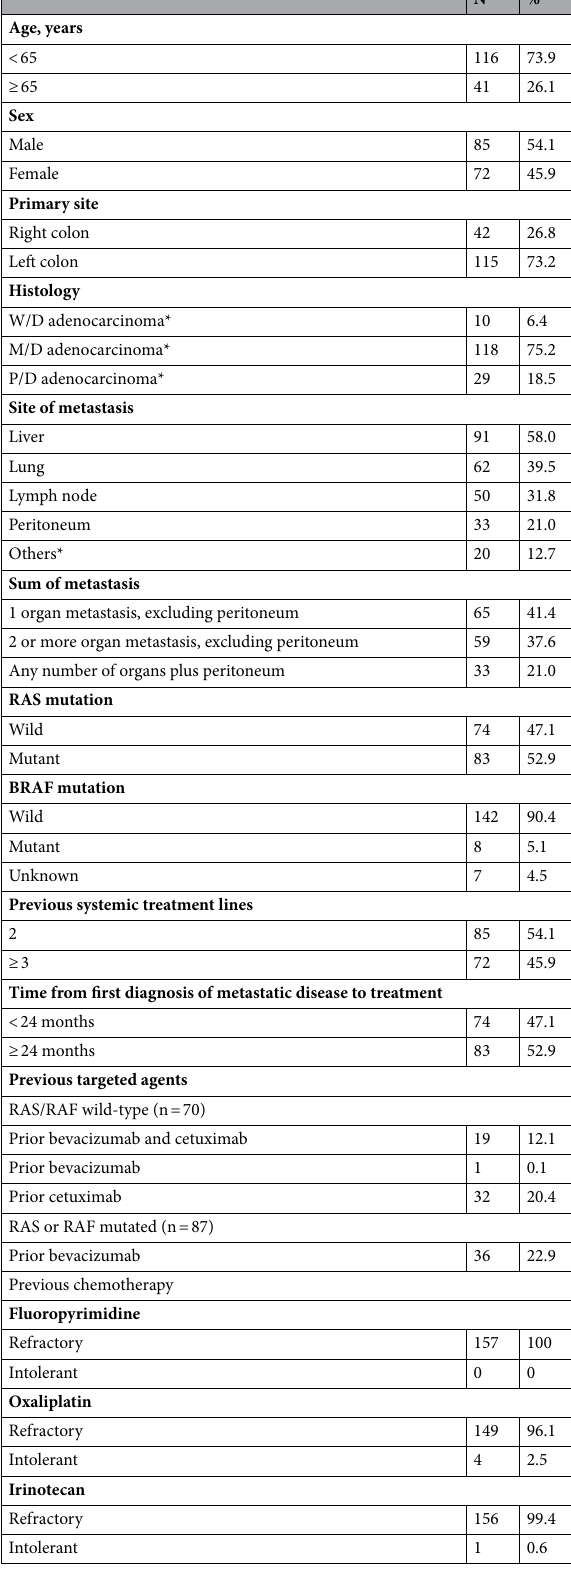
Table 1. Baseline characteristics of all patients (N = 157). *Ovary 4%, bone 8%, etc., 4%. W/D well differentiated, M/D moderately differentiated, P/D poorly differentiated, MSI microsatellite instability,